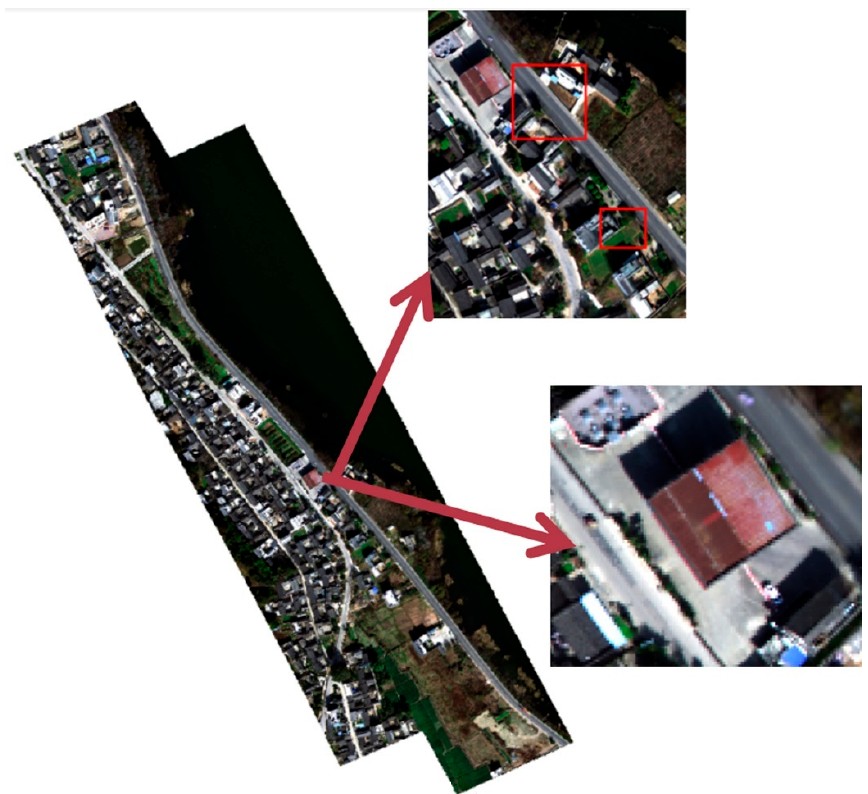
Figure 10. The best stitching image fusion result of an urban scape area.